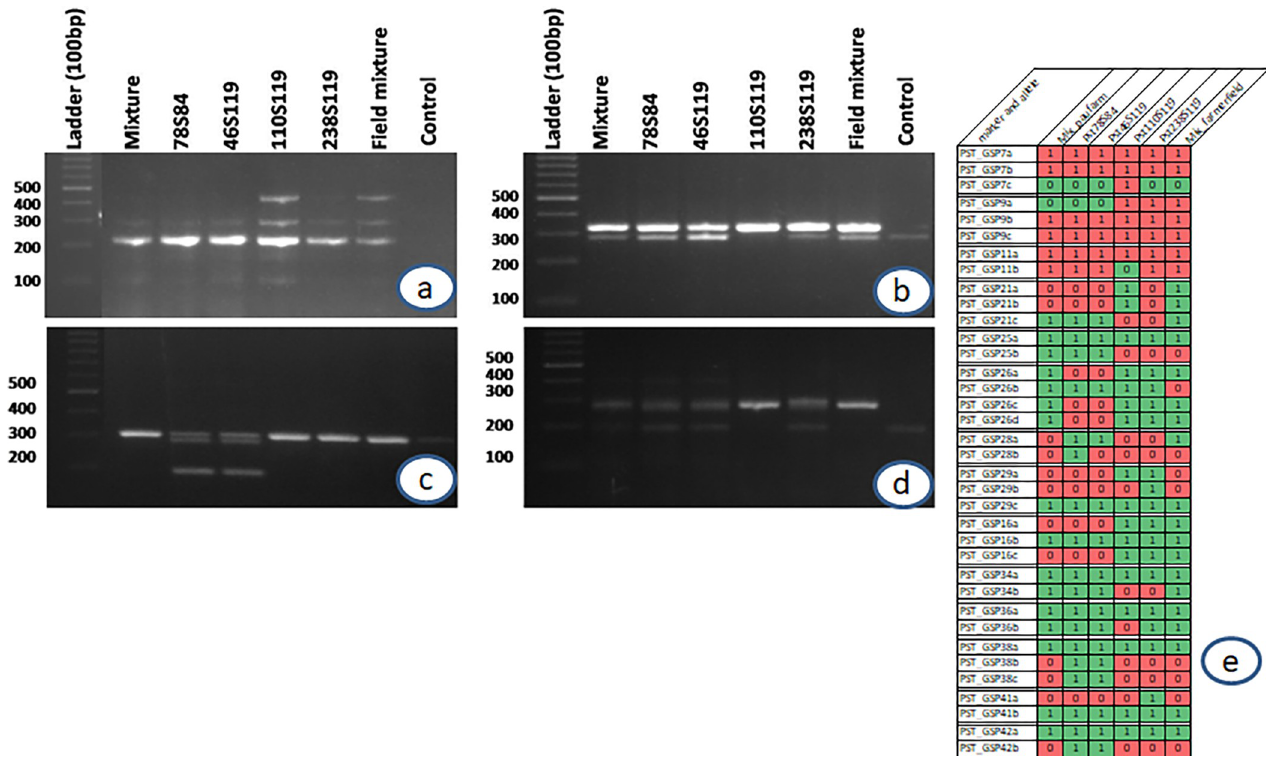
Fig 8. PCR amplification profile of Pst pathotypes for gene specific markers PST_GSP9 (a), PST_GSP11 (b), PST_GSP38 (c), PST_GSP25 (d) and barcoding of Pst pathotypes and field samples based on 15 gene specific